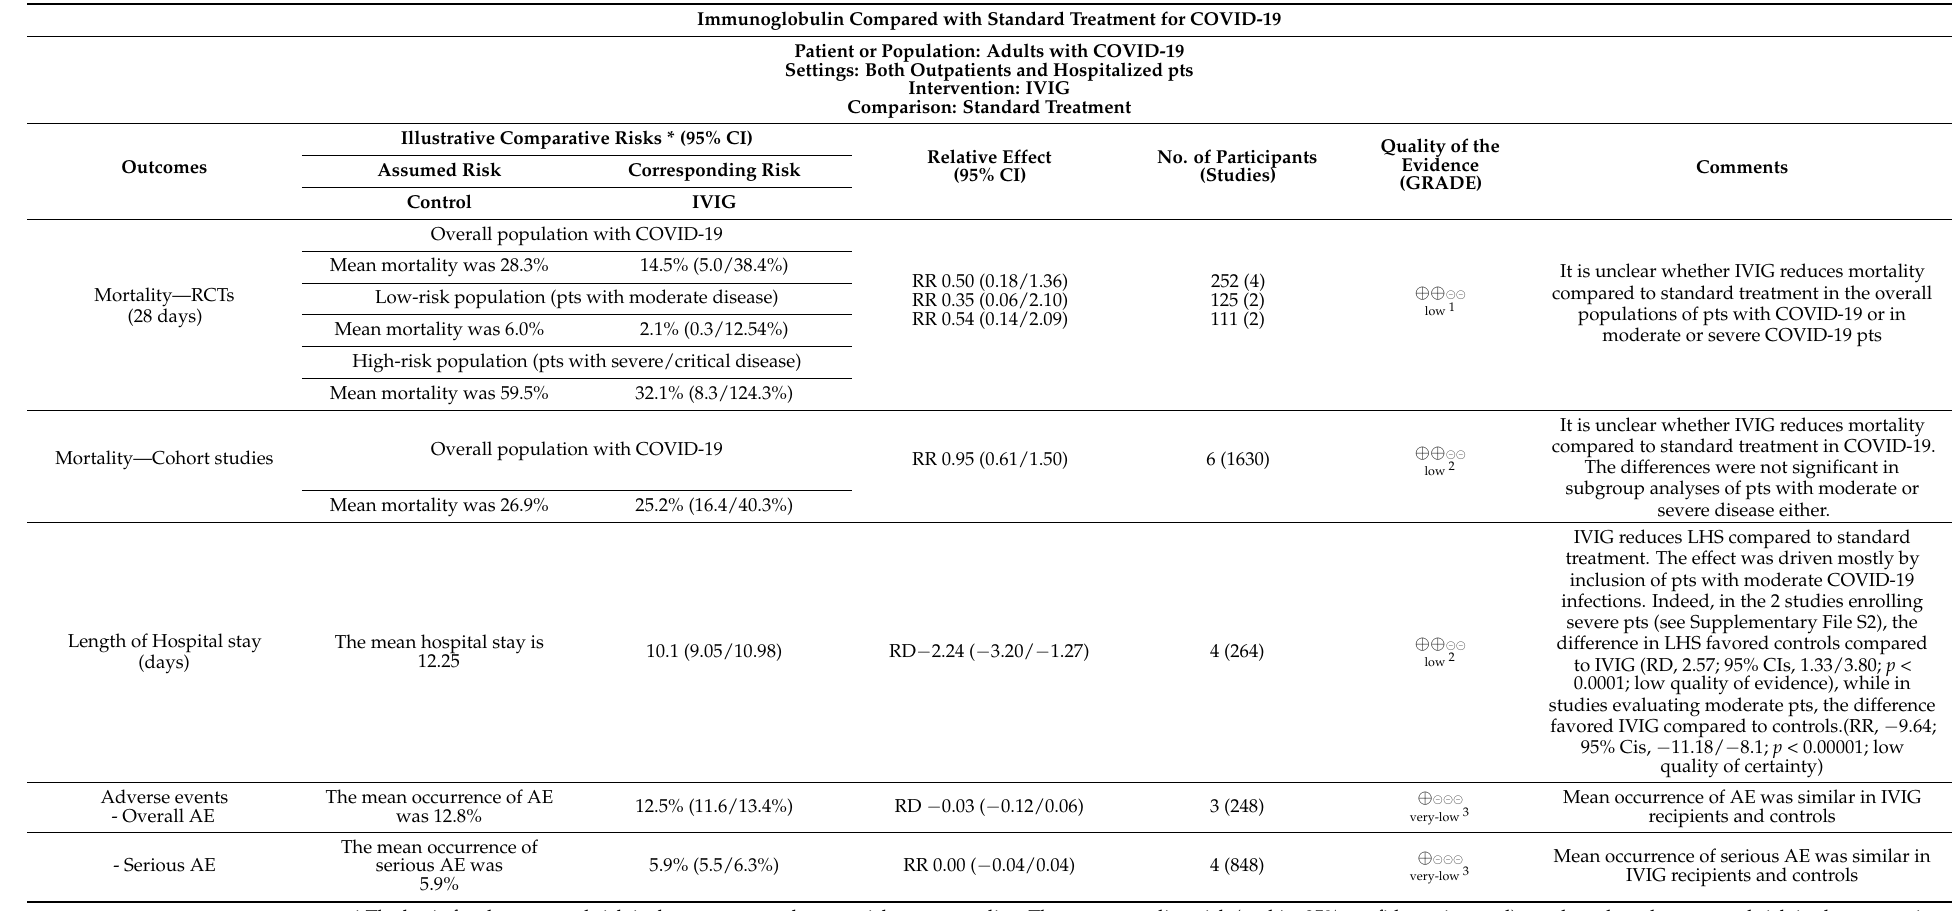
Table 2. Summary of findings table. Immunoglobulin Compared with Standard Treatment for COVID-19 Patient or Population: Adults with COVID-19 Settings: Both Outpatients and Hospitalized pts Intervention: IVIG Comparison: Standard